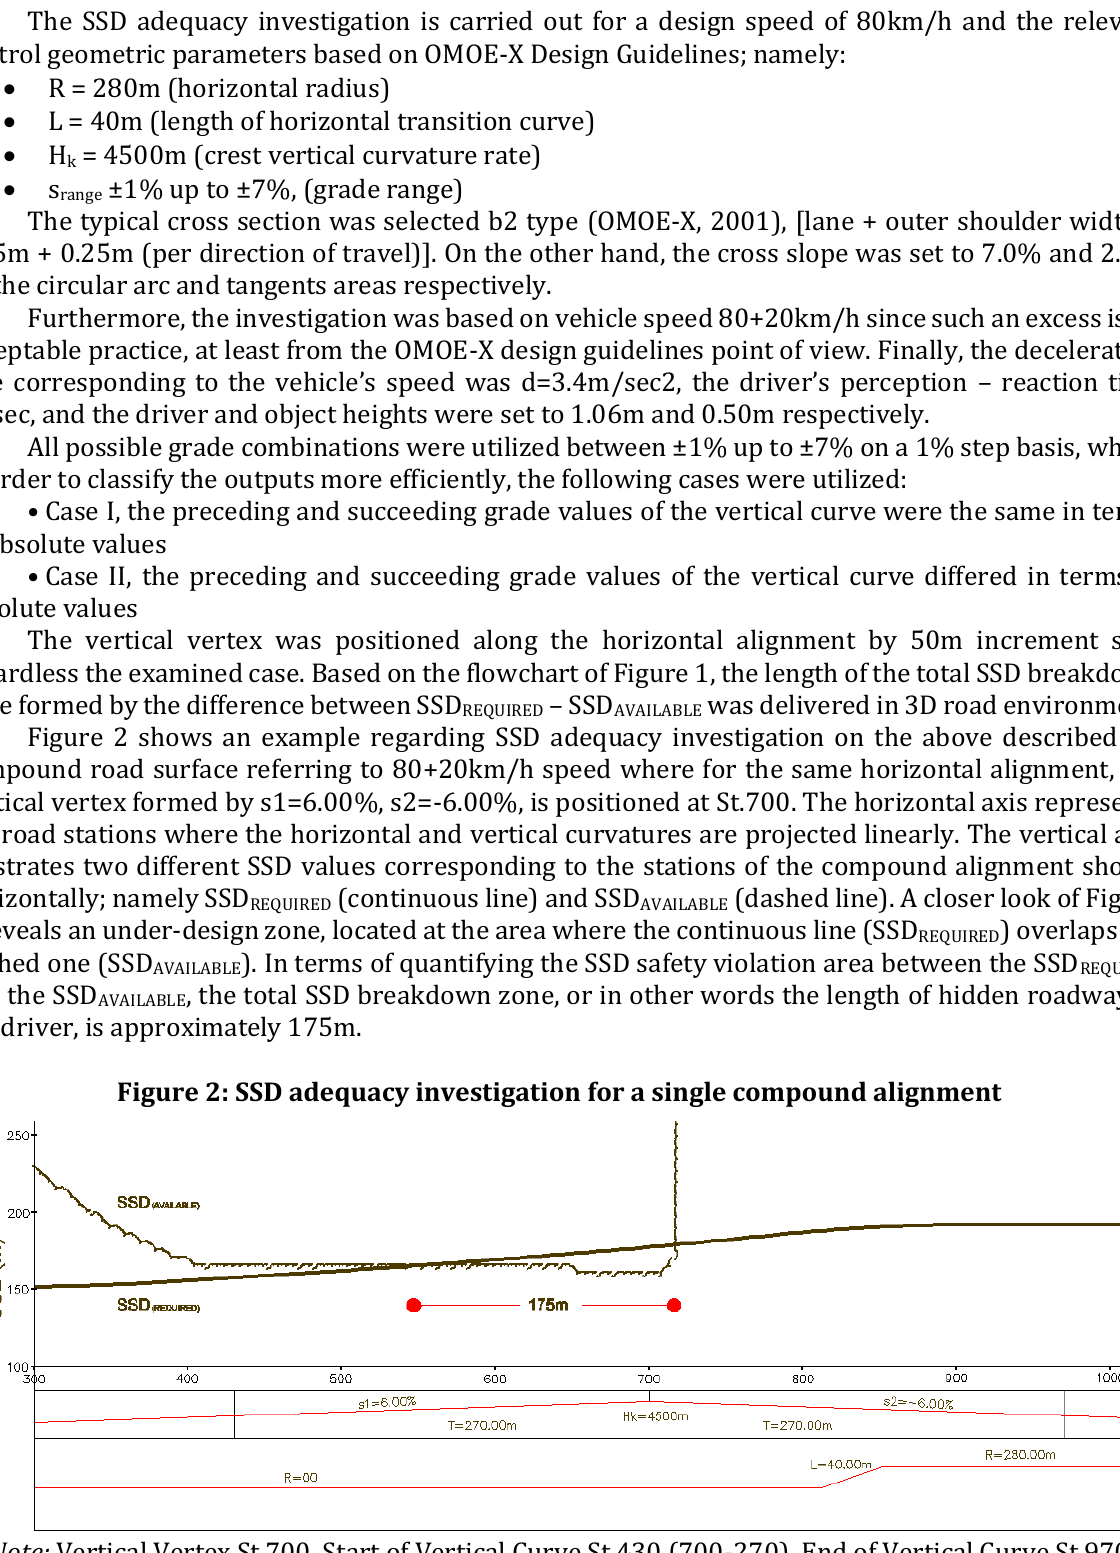
Note: Vertical Vertex St.700, Start of Vertical Curve St.430 (700-270), End of Vertical Curve St.970